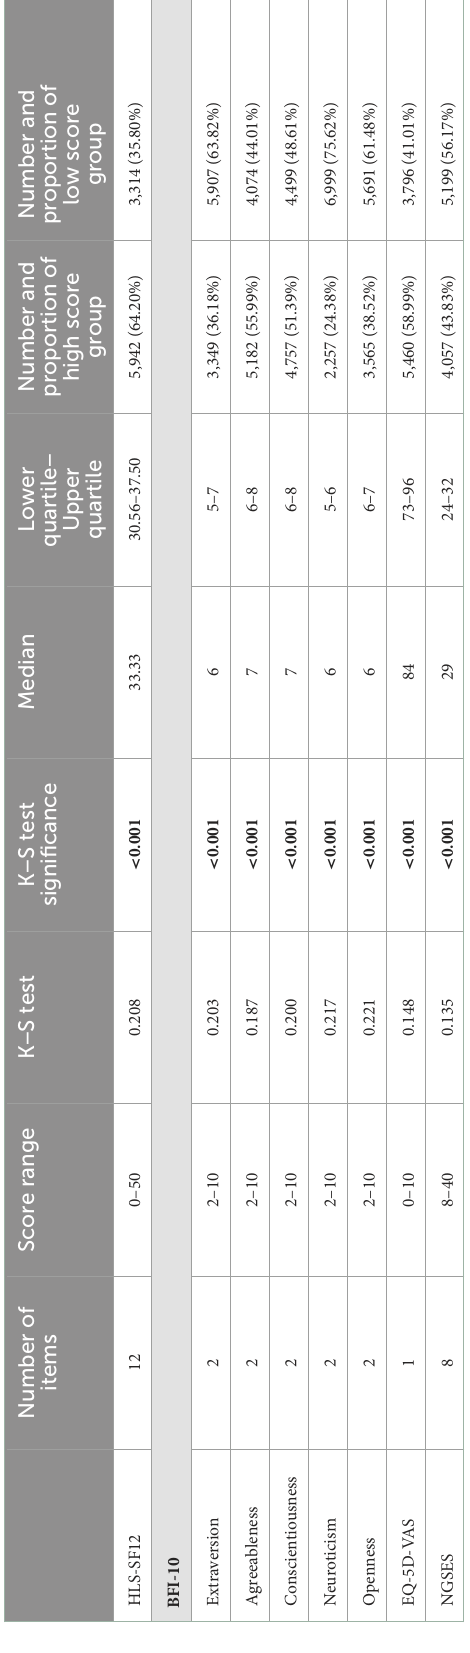
TABLE 4 Descriptive statistics of important considerations for OTC drug